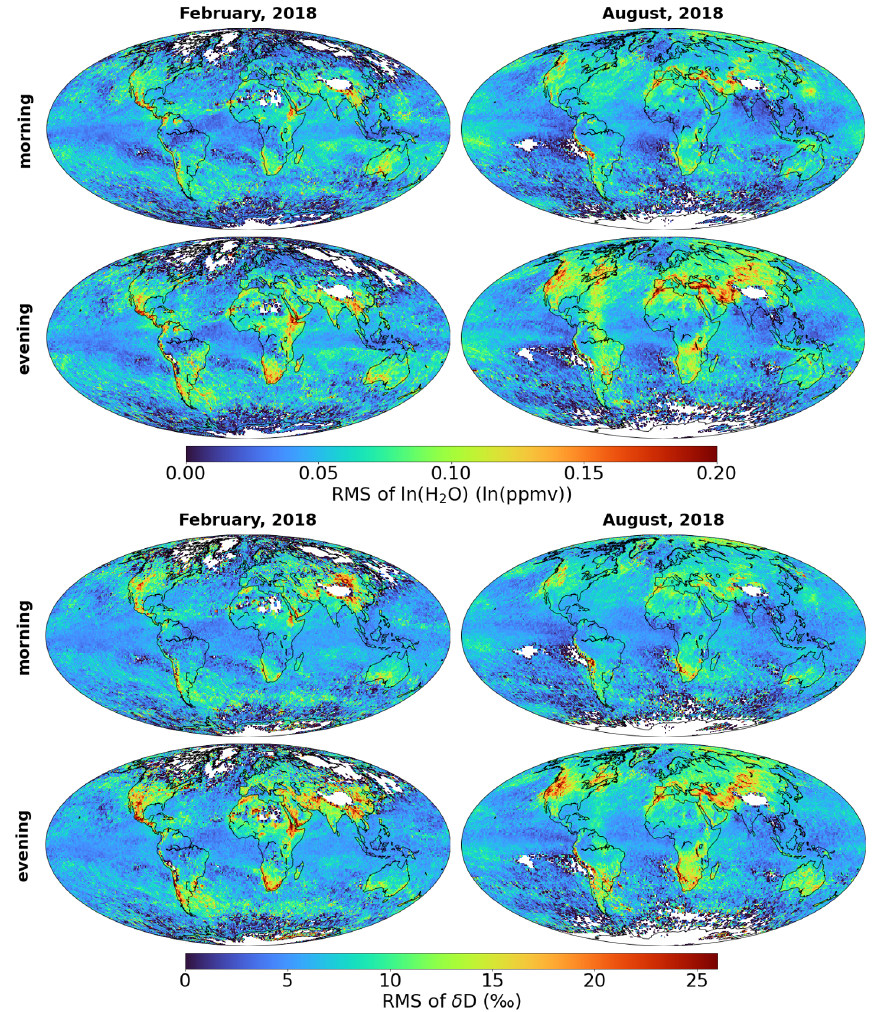
Figure 12. Monthly averages of the rms difference of all data points within the individual 1 ◦ × 1 ◦ grid boxes to their averaged value, evaluated at 4.2kma . s . l . for the quality-filtered H 2 O data on a logarithmic scale (a) and the quality-filtered δ D data (b) . The filtering is performed according to Table